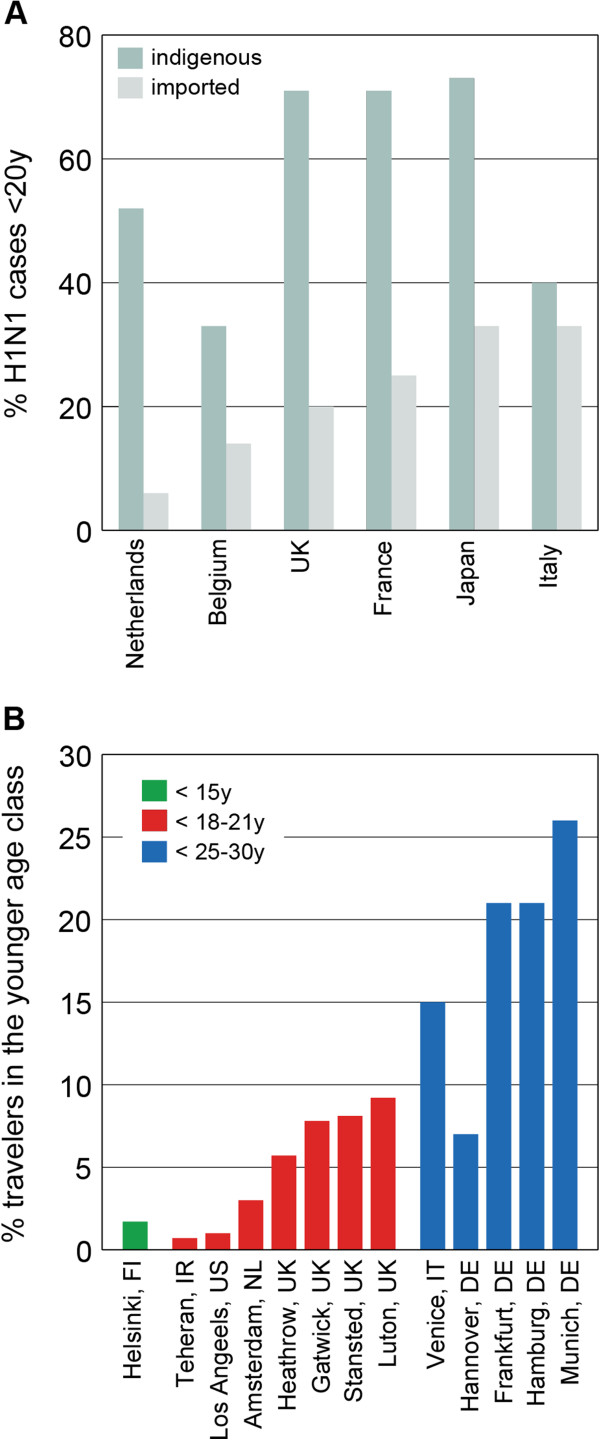
Imported vs. indigenous H1N1 cases and age-specific travel statistics for various countries. (A) Fraction of indigenous cases and of imported cases during the initial phase of the H1N1 pandemic outbreak in the [0–19] years age class, calculated from surveillance data for the following countries: The Netherlands [8], Belgium [9], UK [10], France [11], Japan [13], Italy [12]. (B) Percentage of air-travel passengers in the younger age classes for a set of airports around the world. The age classification used by the demographic statistics vary across countries (Helsinki1, Finland; Teheran3, Iran; Los Angeles2, USA; Amsterdam5, The Netherlands; Heathrow4, Gatwick4, Stansted4, Luton4, UK; Venice6, Italy; Hannover7, Frankfurt8, Hamburg8, Munich8, Germany) with the corresponding age brackets for the children class (expressed in years): 1=[0,15]; 2=[0,18]; 3=[0,19]; 4=[0,20]; 5=[0,21]; 6=[0,25]; 7=[0,26]; 8=[0,30]. Sources of the data are reported in the Additional file 1. The statistics found for Italy and Germany correspond to larger age brackets. If we rescale the data as indicated in the Demographic and travel data subsection, we obtain the following estimates for the percentage of travelers in the [0–18] years old class: 1.05% (Venice), 0.49% (Hannover), 2.31% (Frankfurt), 2.31% (Hamburg), and 2.86% (Munich). These estimated values are consistent with the data.